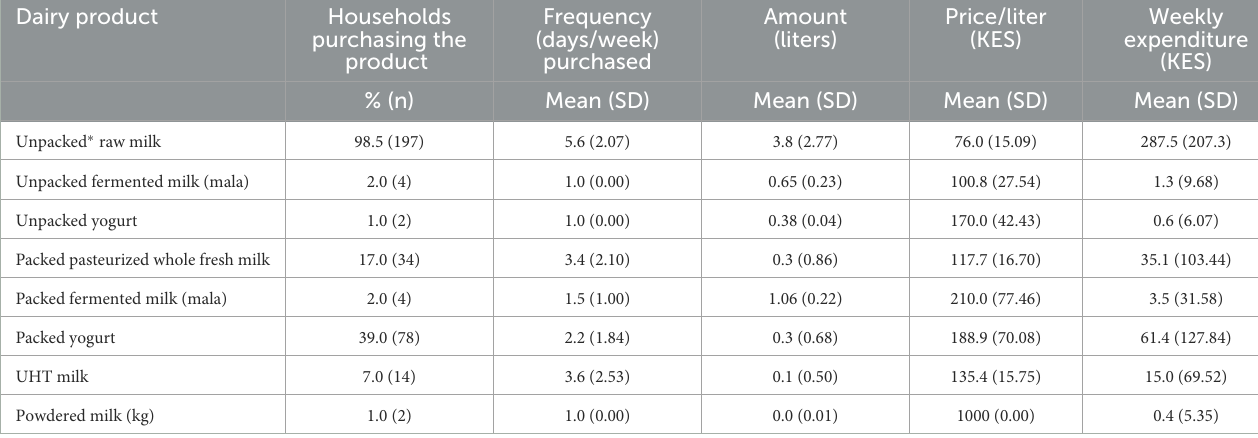
TABLE 2 Households purchasing patterns for different dairy products in the past 7 days ( n = 200). Dairy product